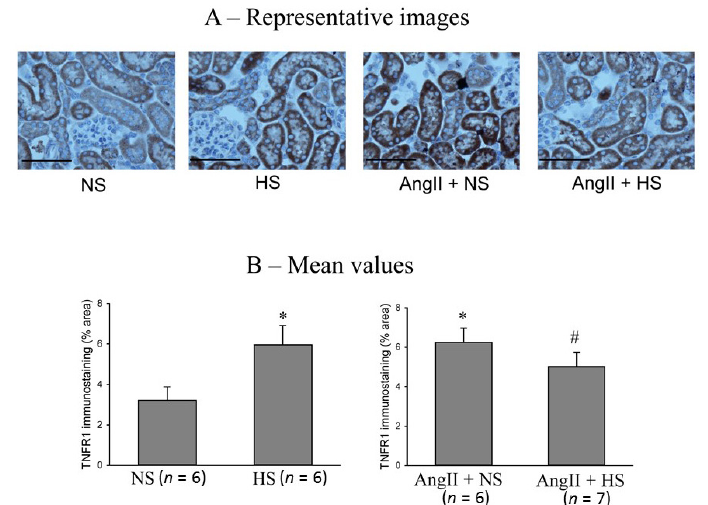
Figure 6. TNFR1 immunostainings in renal slices. (A) the representative images and (B) the mean values of percent area of positive staining for TNFR1 protein expression. The scale bar indicates 100 µm. * : P < 0.05 vs. NS; #: P = 0.068 vs. AngII +